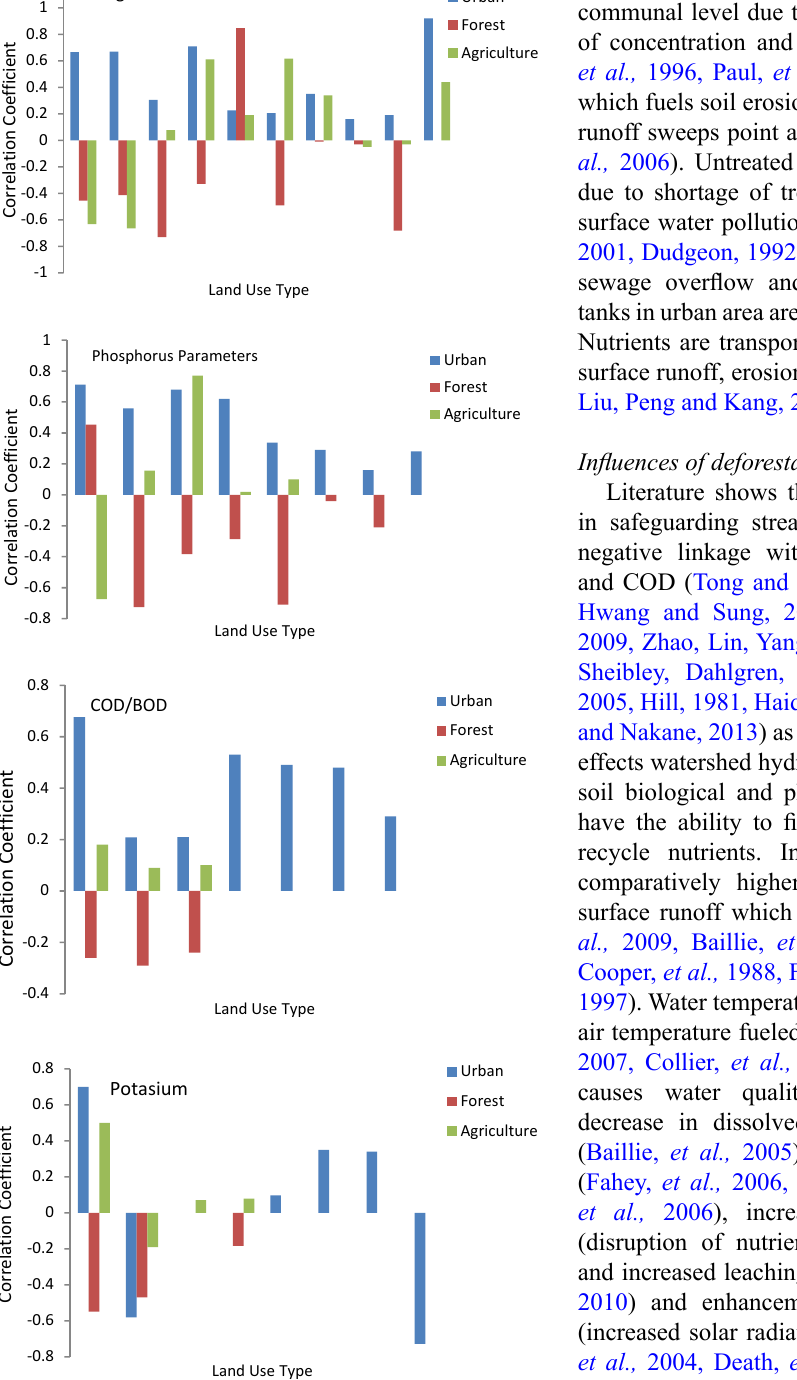
Fig. 2: Correlation between urban, forest and agriculture land uses with N-Parameters, P-Parameters and